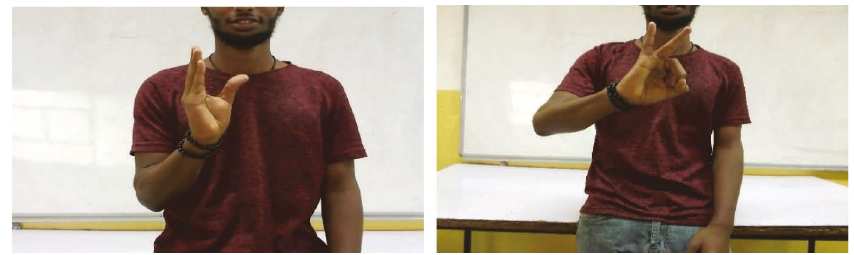
Figure 5: Signs for different Amharic character. Table 2: Amharic words to represent the number of classes for the model